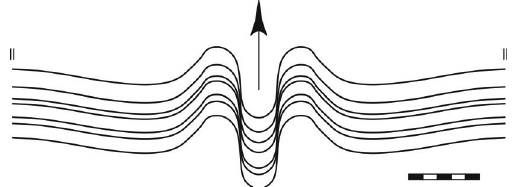
Fig. 42. Lituites perfectus Wahlenberg, 1818 from the Upper Grey Orthoceratite Limestone; lirae in the neotype MB.C.30544 (Neben Coll.) from Niederfinow (Brandenburg), at wh = 11 mm. Scale bar units = 1